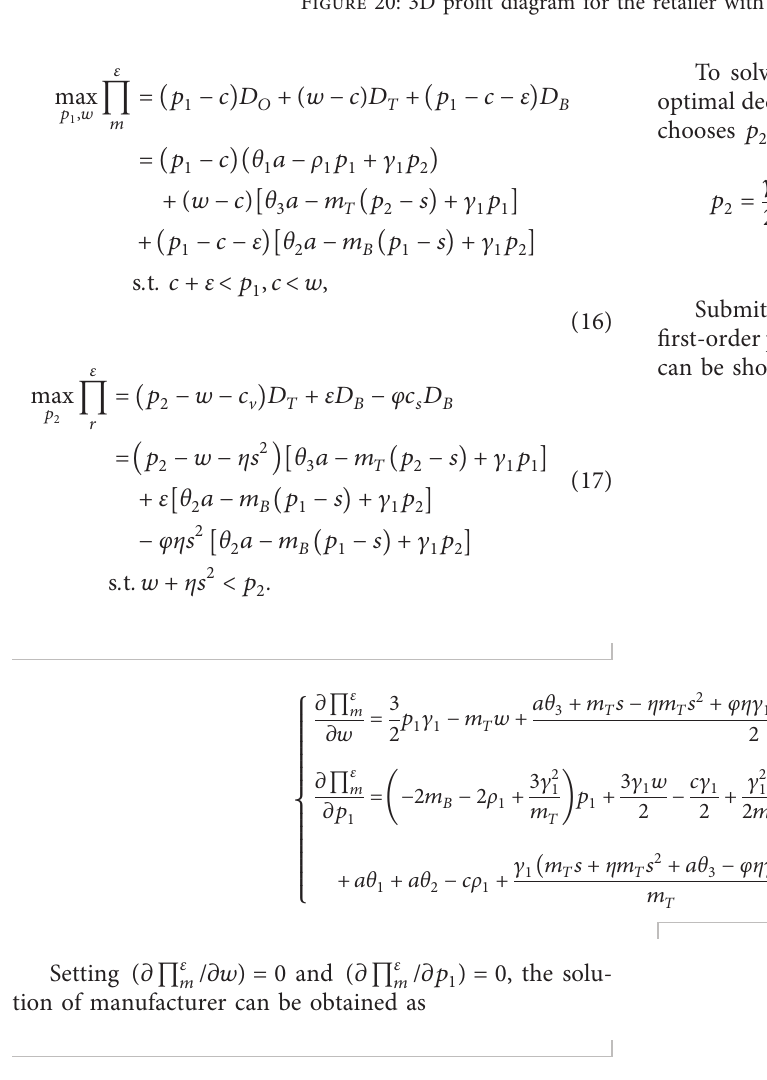
� 0 . and s , as α 2 1